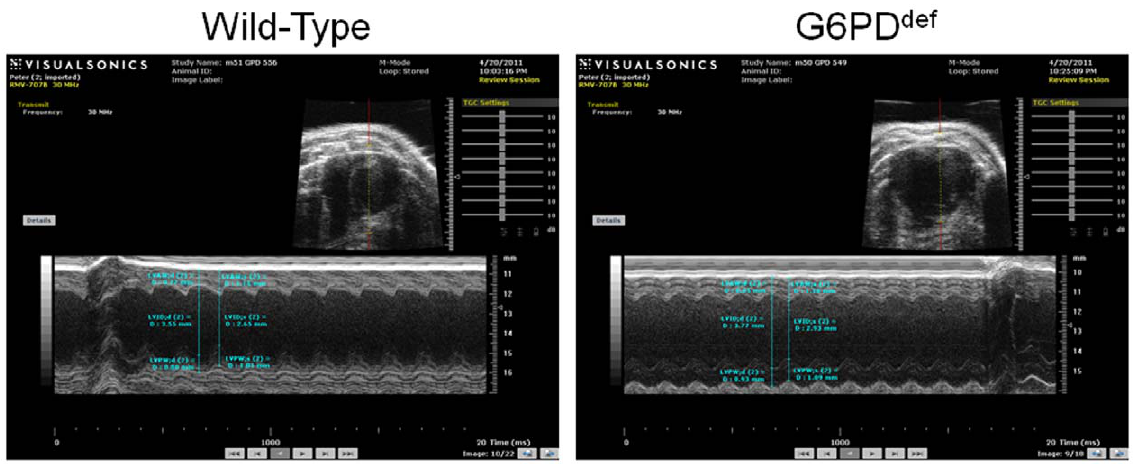
Figure 6. M-mode echocardiography performed on wild-type and G6PD deficient mice hearts is shown.